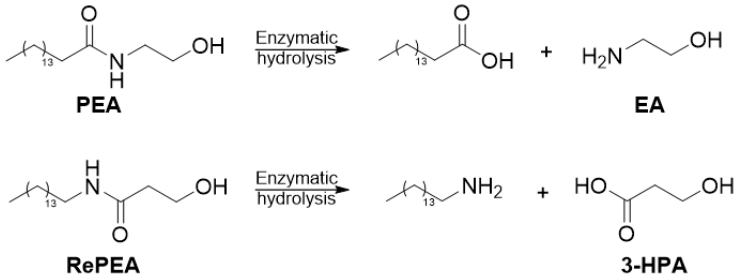
Figure 6. Enzymatic hydrolysis of PEA and RePEA affording ethanolamine (EA) and 3-hydroxypropionic acid (3-HPA), respectively.